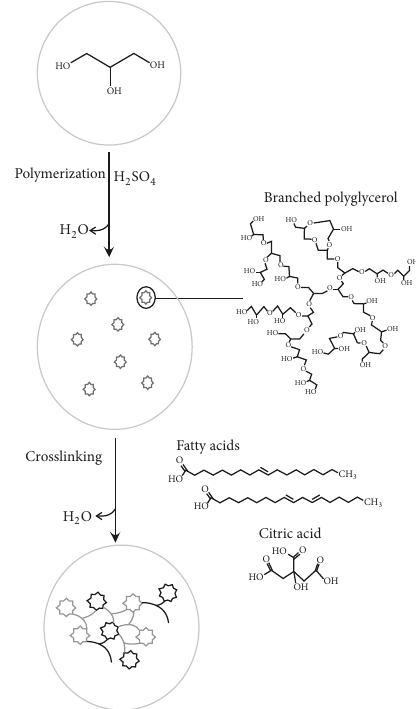
Figure 1: Schematic representation of hydrogel synthesis. First, the glycerol polymerization and the subsequent addition of crosslinking